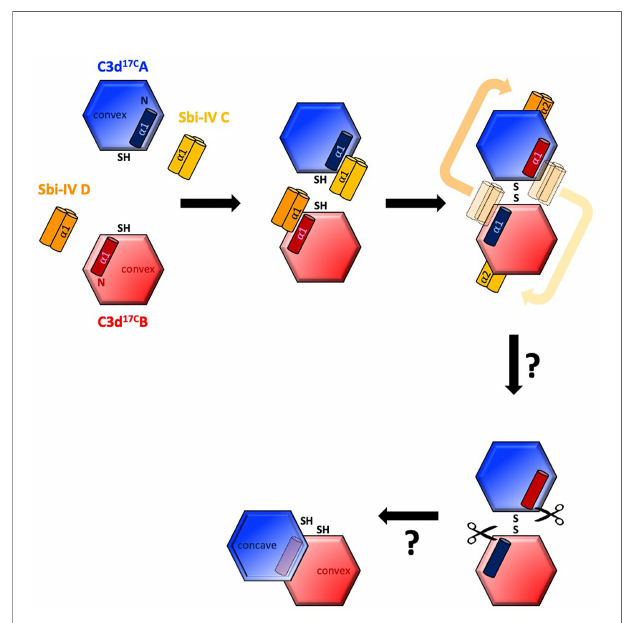
FIGURE 5 | Schematic model depicting the proposed mechanistic basis behind Sbi-IV-induced N-terminal helix swapping of dimeric C3d. Top left: In the fl uid phase, Sbi-IV helix a 1 binds to the N-terminal helix a 1 and its adjoining loop on the convex thioester-containing face of C3d 17C monomer. Top middle and right: When two Sbi-IV-bound C3d 17C monomers come into close proximity, Sbi-IV helix a 2 is attracted to and binds the concave face of C3d 17C (a more favourable higher af fi nity interaction), pulling C3d 17C helix a 1 along with it, resulting in a reciprocal exchange of the N-terminal a 1 helices of the two C3d 17C monomers. Bottom: The truncated rat C3dg dimer might be a relic of a helix swapped dimer, in which helix a 1 has become more susceptibility to further proteolytic degradation following the 3D domain swap. This leads to the formation of a more compact dimer in which the hydrophobic surfaces exposed after proteolysis of both a 1 helices face each other (see also Supplementary Figure S5